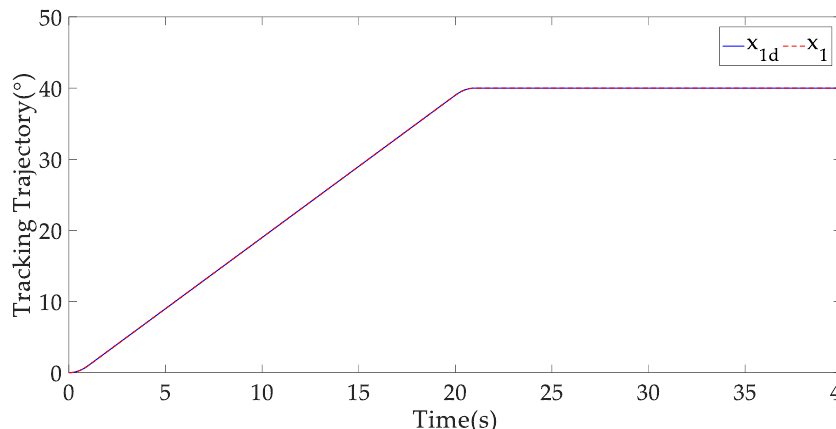
Figure 3. The tracking trajectory of NRC.